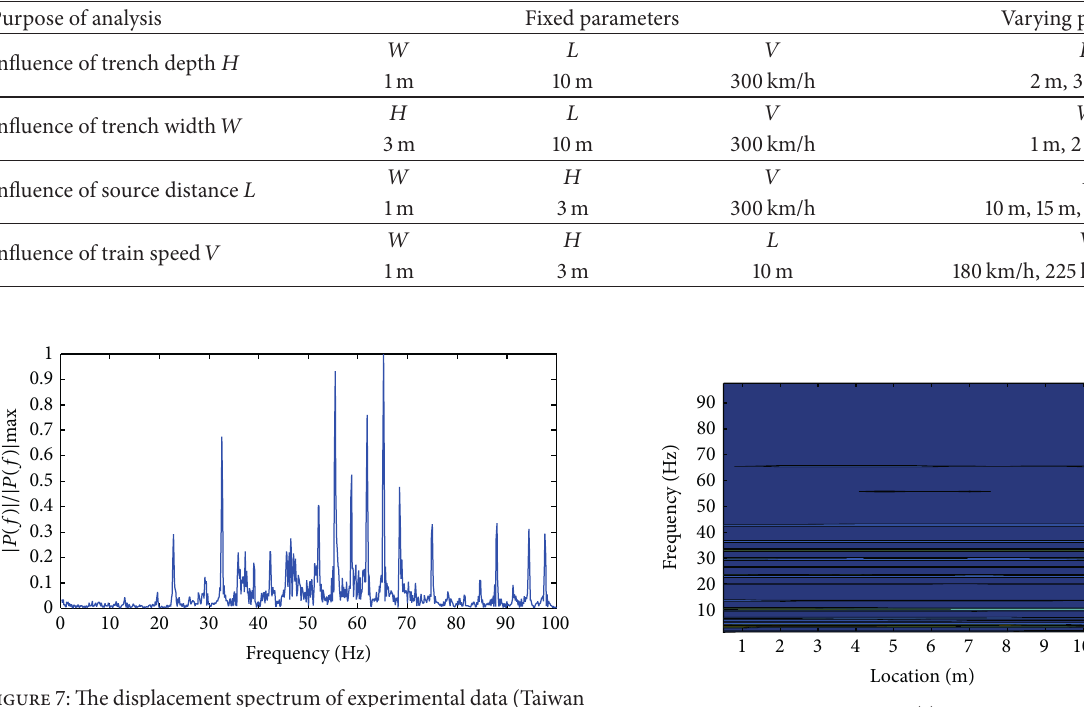
Figure 7: The displacement spectrum of experimental data (Taiwan High Speed Rail).